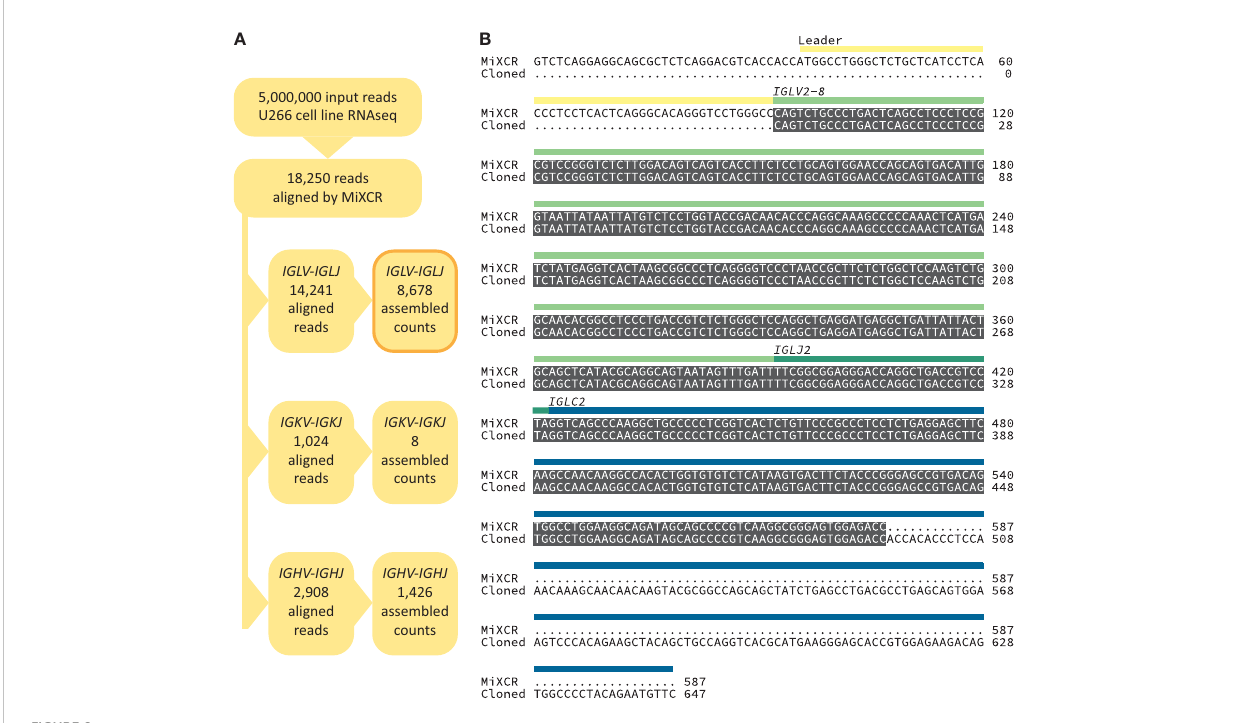
FIGURE 2 Accurate recovery of U266 IGV L -IGJ L sequence. (A) RNAseq reads aligned by MiXCR to immunoglobulin loci. (B) Alignment between U266 IGLV2-8- IGLJ2-IGLC2 sequences derived from untargeted RNAseq data (54) using MiXCR and standard cloning methods (55). Identical regions are highlighted in grey. The regions of the monoclonal sequences are shown with yellow, green and blue